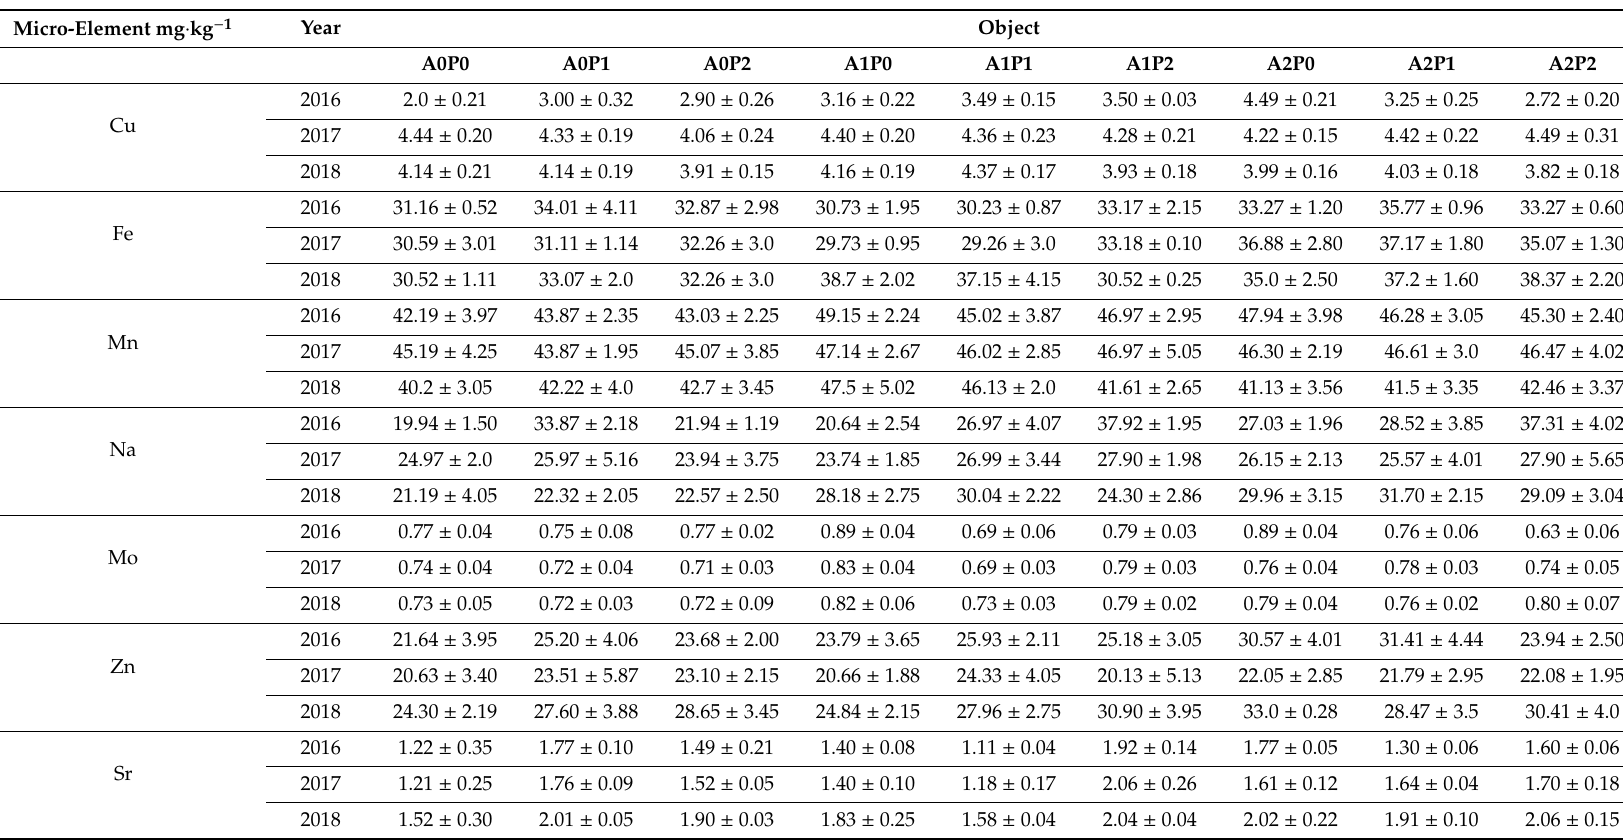
Table 3. The average copper (Cu), iron (Fe), manganese (Mn), sodium (Na), molybdenum (Mo), zinc (Zn), and strontium (Sr) content (mg · kg − 1 ) in oat grain depending on the combination of algae fertilization and magnetic field stimulation in